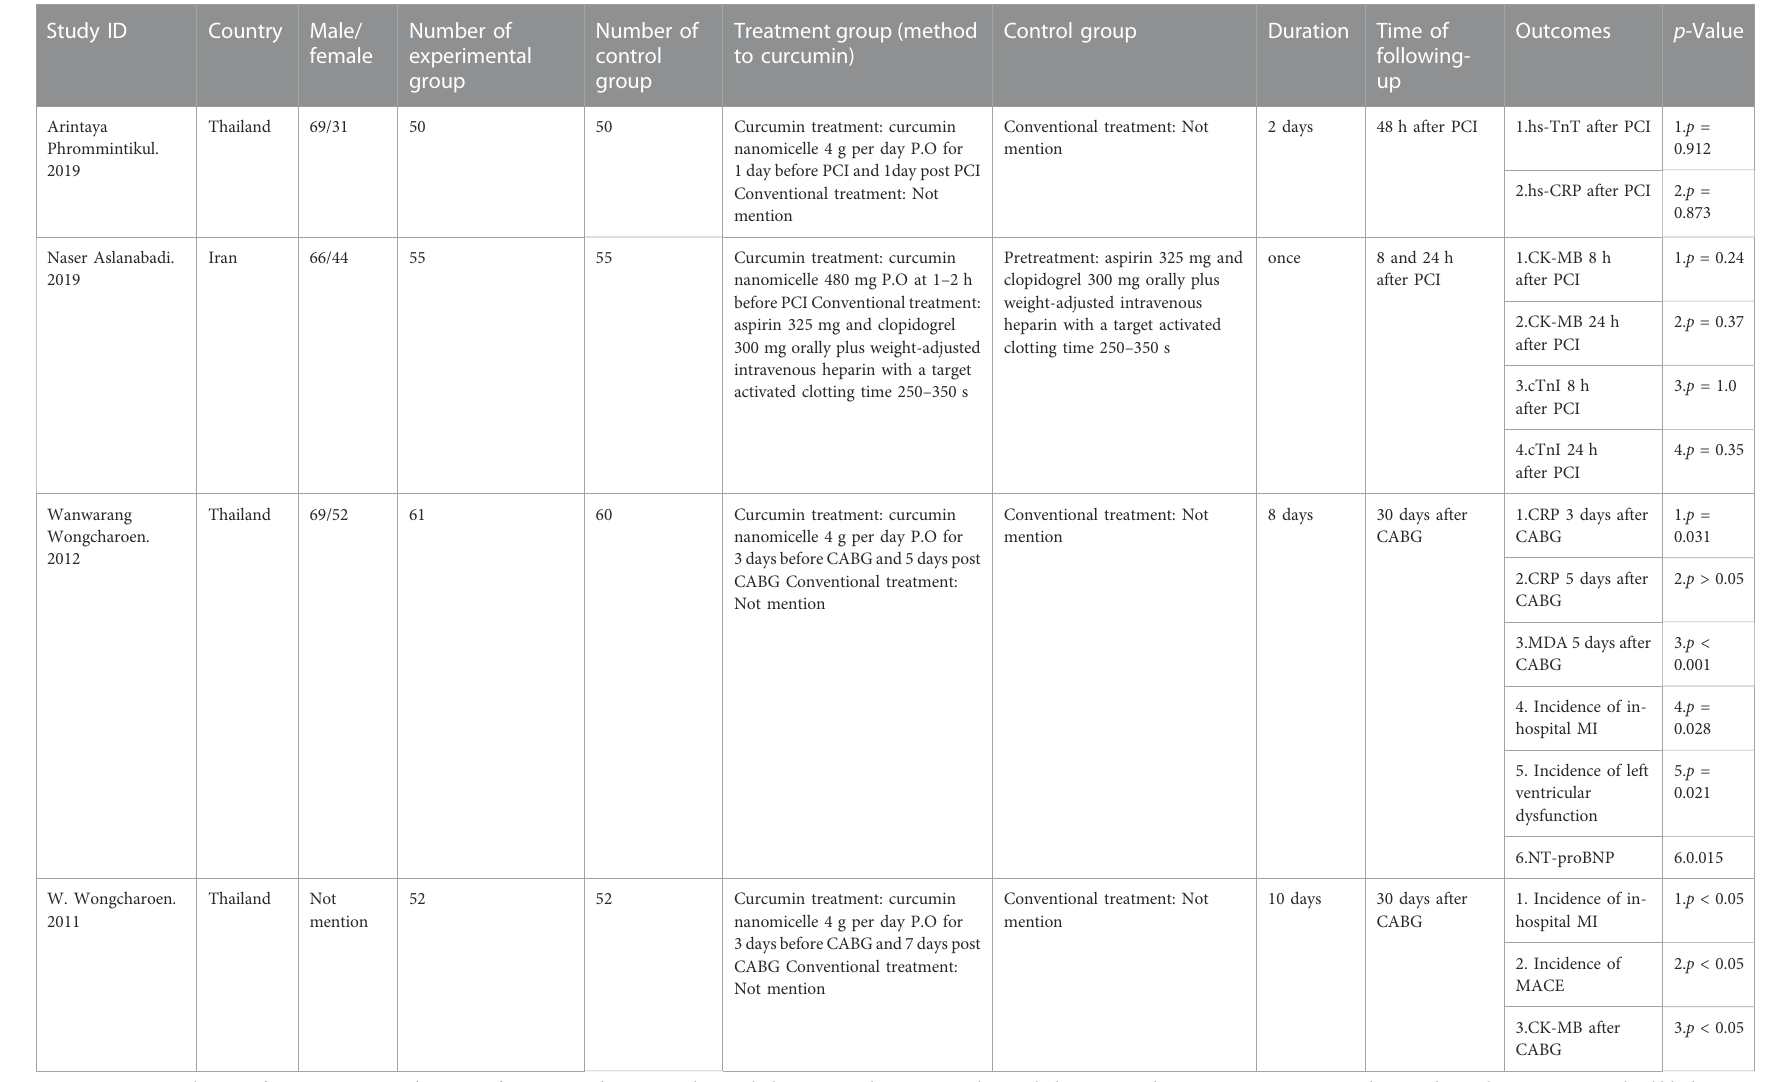
TABLE 2 Basic characteristics of the four included human